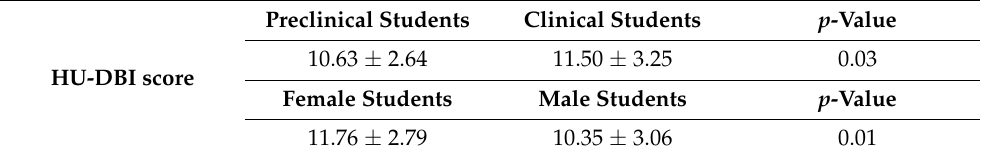
Table 5. HU-DBI scores of the preclinical/clinical female/male dental students (mean ± SD).